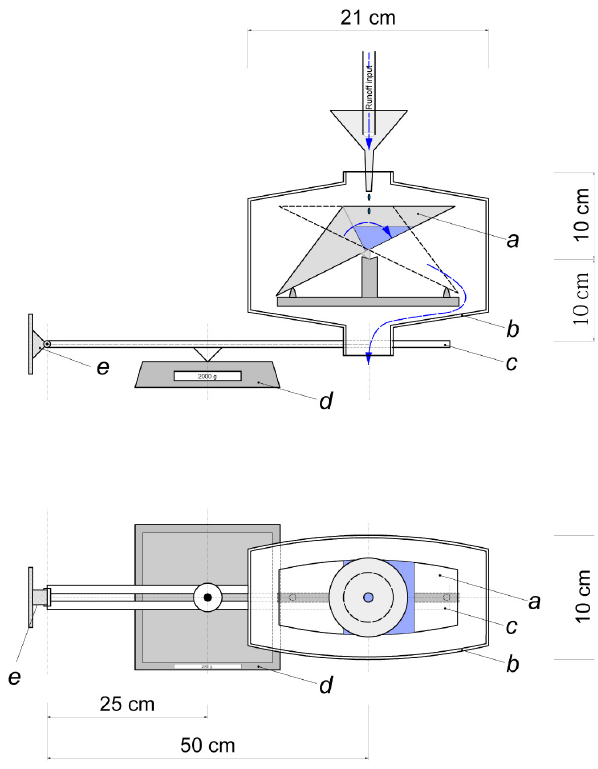
Fig. 2. Diagram of the weighable tipping bucket system. The blue arrow indicates the way the water has to go when leaving the (a) tip- ping bucket and (b) the box. The other parts of the set-up are (c) the lever connected to the balance by a screw, (d) the balance and (e) the